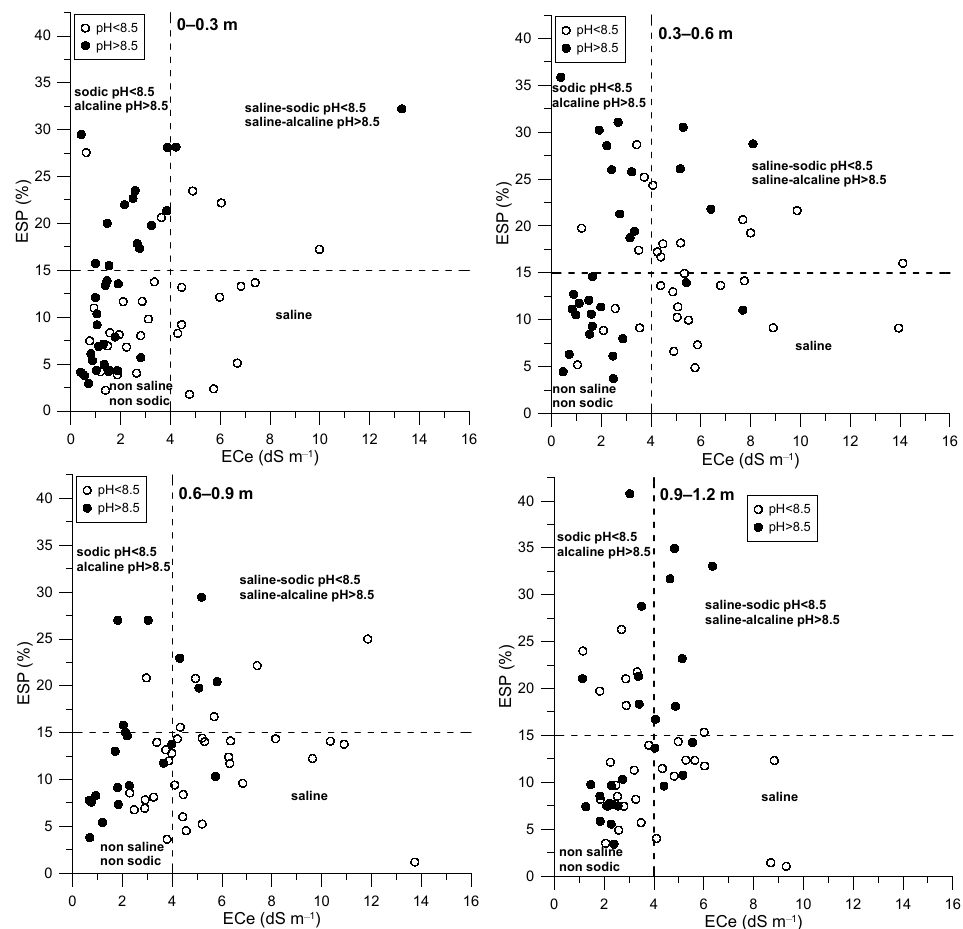
Figure 7. Classification of the samples taken in 2017 (Figure 1), according to the percentage of exchangeable sodium (PSI), the electrical conductivity measured in the saturated paste extract (ECe), and the pH for the four depths.